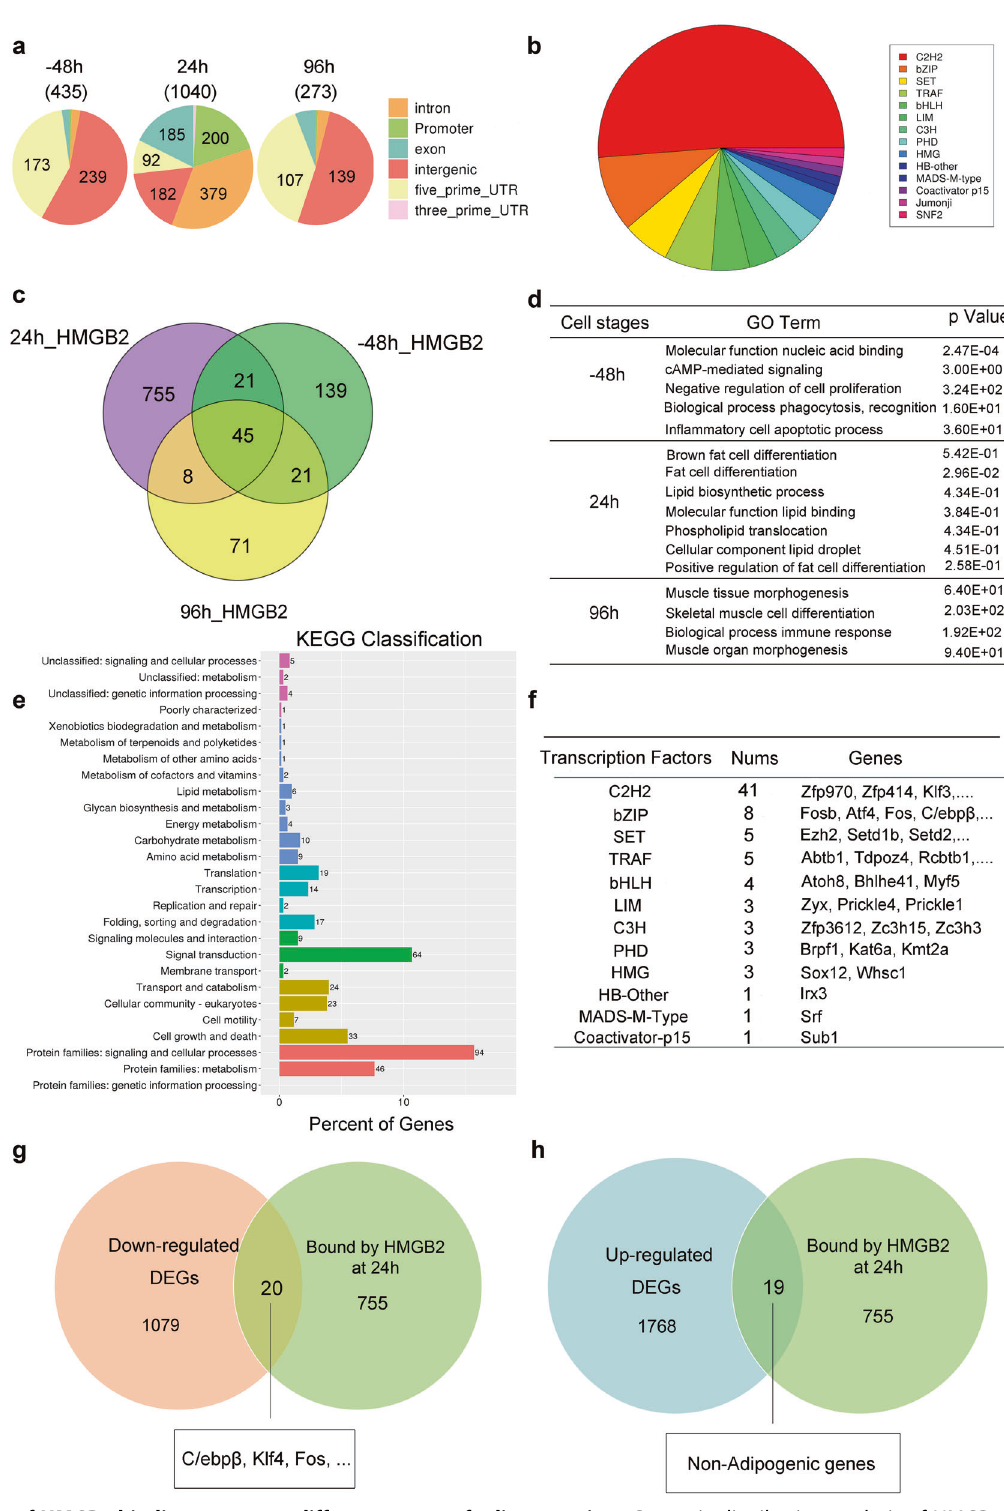
Fig. 5 Analysis of HMGB2 binding targets at different stages of adipogenesis. a Genomic distribution analysis of HMGB2 binding regions using ChIP-seq data at different sampling time points. b Classi fi cation analysis of HMGB2-target genes at MCE stage by iTAK software (version 1.7a). c Venn diagram for the numbers of genes bound by HMGB2 on different sampling time points. d GO enrichment for the biological process that HMGB2 participates in. e KEGG classi fi cation of HMGB2 at 24 h. f Classi fi cation of transcription factors and the numbers that bound by HMGB2. g, h Venn diagram about genes screened using RNA-seq and ChIP-seq data at 24 h.